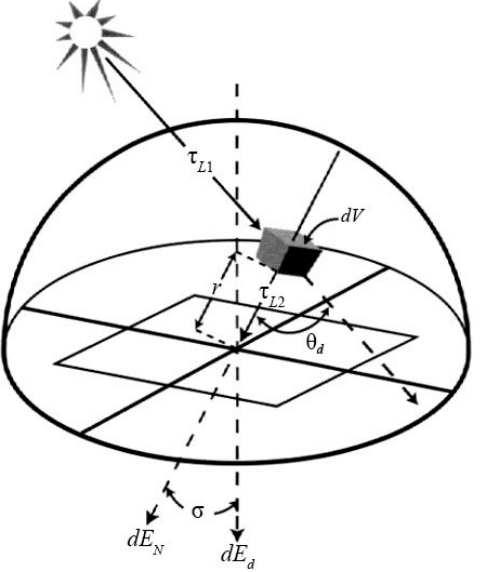
Figure 1. Contribution to the downwelled irradiance from a unit volume.